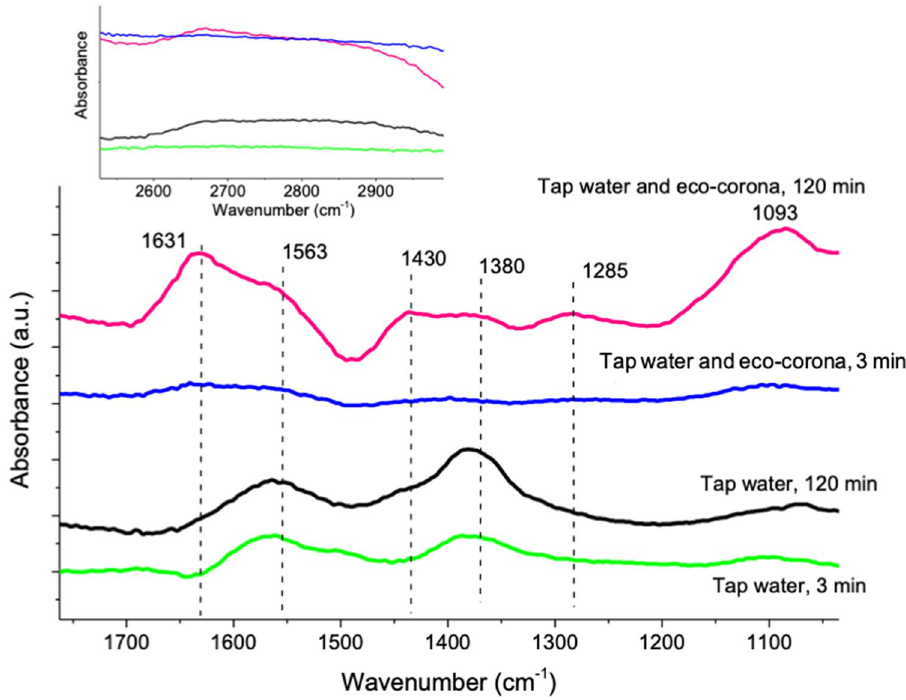
Figure 5. ATR-FTIR spectra for Co NPs in tap water, with and without eco-corona biomolecules, after 3 and 120 min. The inset shows the CH-stretching region for the same spectra. The spectra have been offset for